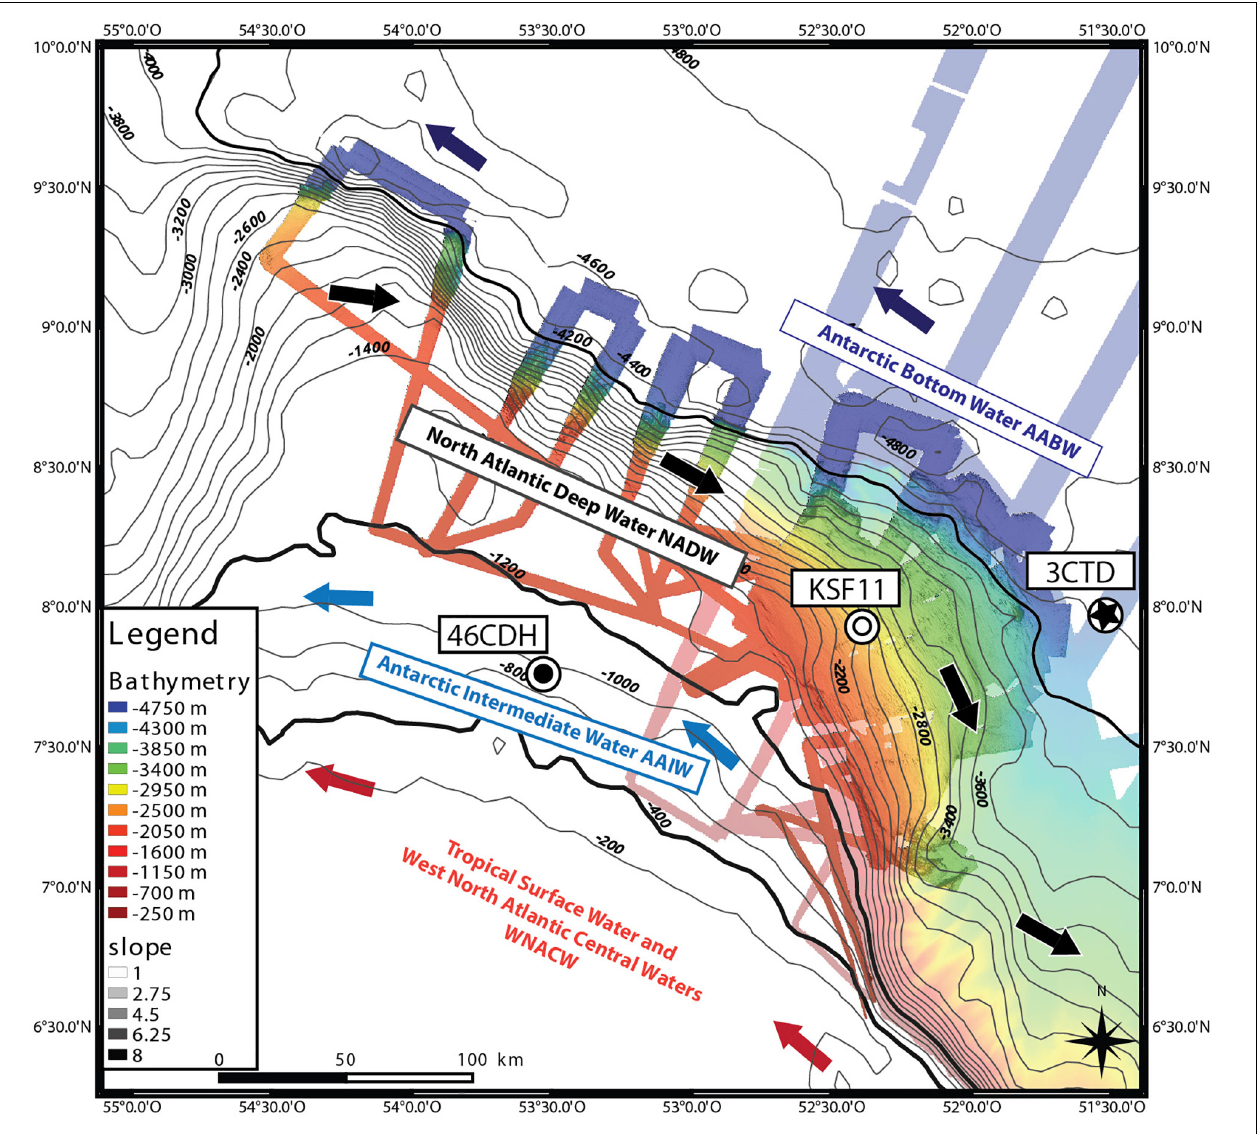
FIGURE 1 | Bathymetric map of the Demerara Plateau and location of studied core IG-KSF-11. The arrows represent surface (red), intermediate (blue), and deep (black) ocean circulation patterns. Also shown for comparison are the location of reference core 46CDH (Huang et al., 2014) and hydrocast station 3CTD (Huang et al.,